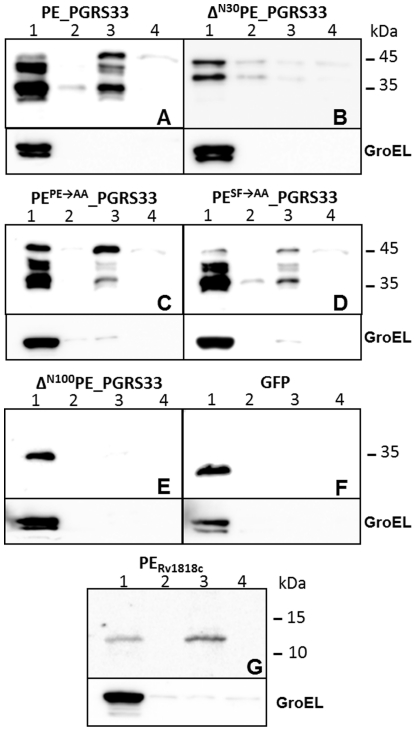
Subcellular fractionation
analysis of
M. smegmatis
 expressing different proteins. A) PE_PGRS33; B) ΔN30PE_PGRS33; C) PEPE→AA_PGRS33; D) PESF→AA_PGRS33; E) ΔN100PE_PGRS33; F) GFP; G) PERv1818c. All constructs were expressed from PRv1818c with the exception of that shown in panel B, which was expressed from Phsp60. Lane 1: cytoplasmic fraction; lane 2: membrane fraction; lane 3: cell wall fraction; lane 4: Genapol supernatant. Proteins were detected by Western blot using monoclonal antibodies against GFP, HA, or GroEL.